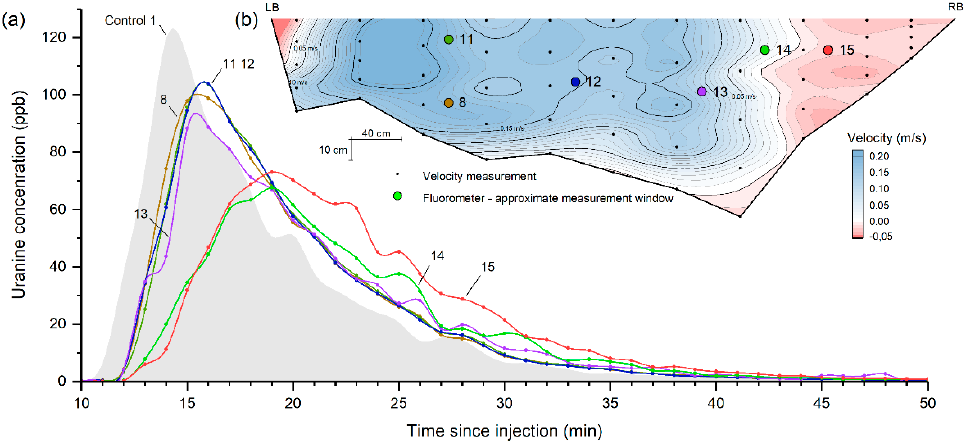
Figure 4. ( a ) Breakthrough curves for each fluorometer of cross-section 1. Control fluorometer is placed 10–15 m upstream of the section (Figure 1). ( b ) Velocity profile of cross-section 1 and location of the fluorometers (LB: left riverbank; RB: right riverbank).